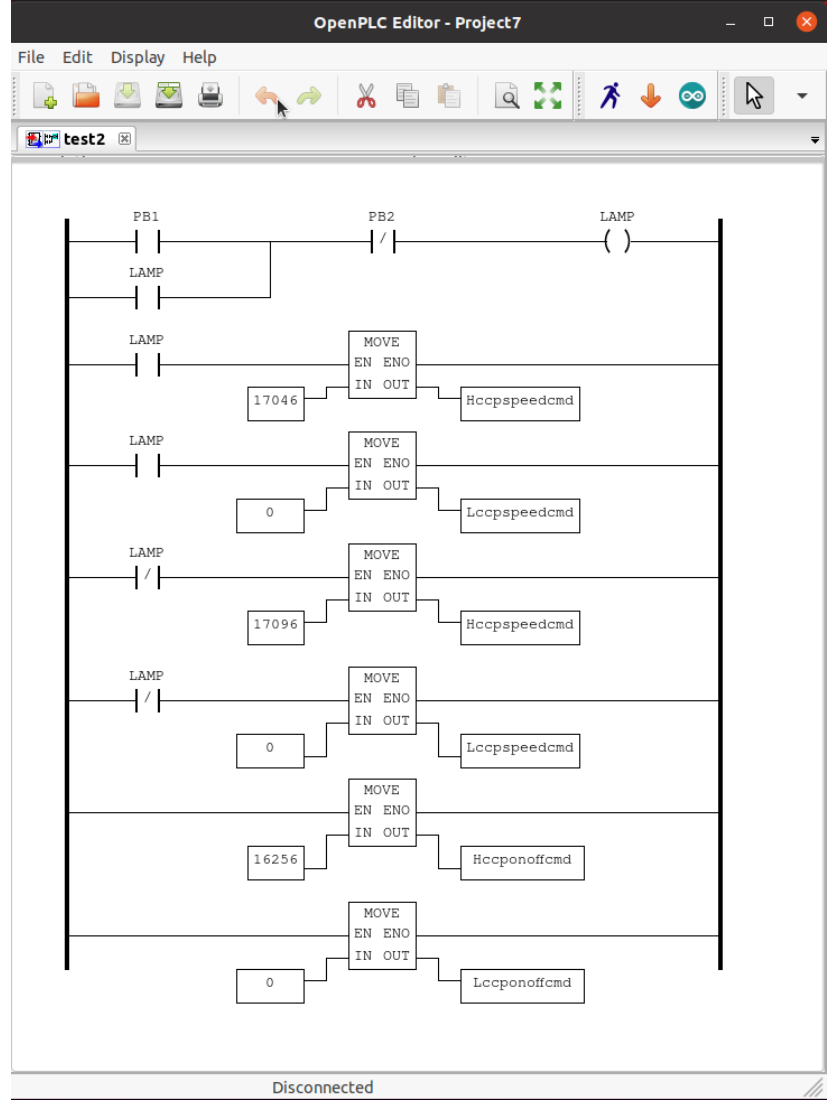
Figure 15. Rogue PLC ladder program in OpenPLC Editor. Table 6. Rogue PLC ladder program local